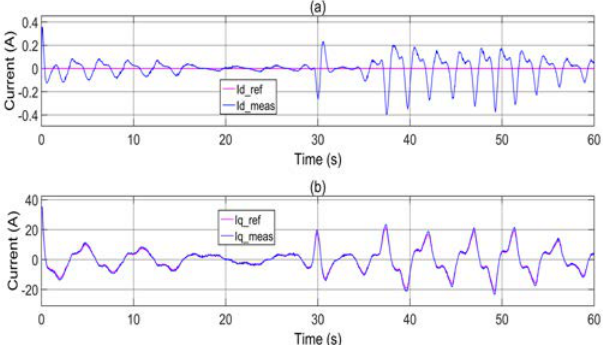
Fig. 13. Performance of the proposed controller for Case II, 0-29 s, and Case III, 30-60s. (a) d -axis referenced and measured currents; (b) q -axis referenced and measured currents.